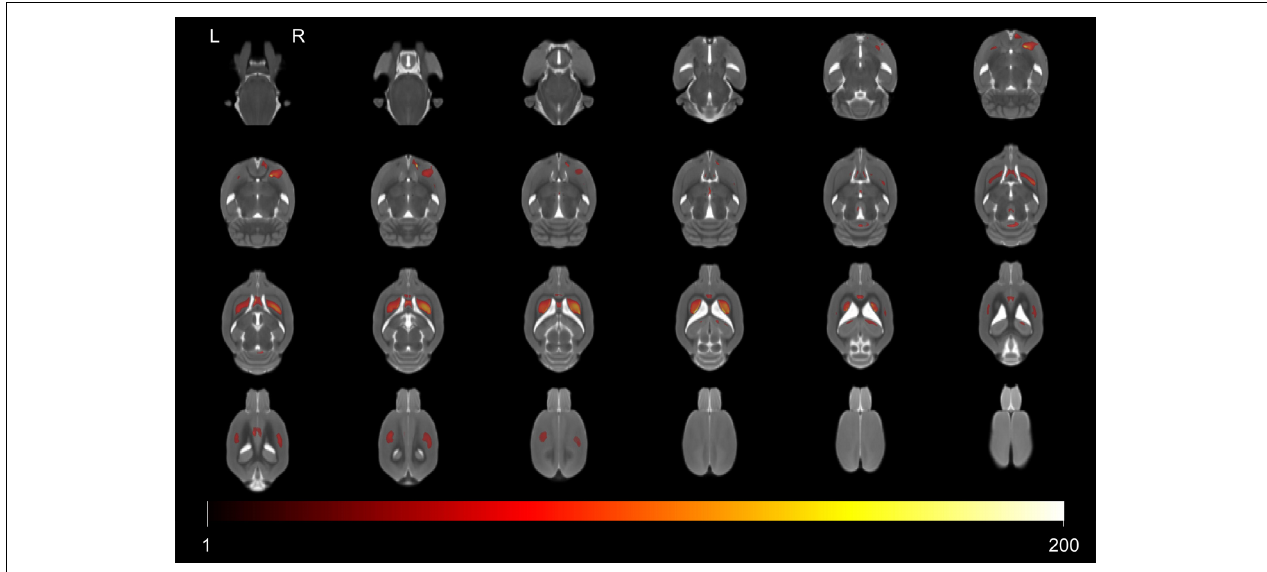
FIGURE 2 | Colored voxels superimposed on the T2-weighted MRI template represent clusters with the interactions of group and age on gray matter volume (FWE, P -value < 0.05; threshold of 200 voxels). All 13 clusters included the septal region, bilateral caudate putamen, hippocampus, primary somatosensory cortex, cerebellum, periaqueductal gray, right accumbens nucleus, and thalamus. Note that L and R represent the left and right sides of the brain, respectively.